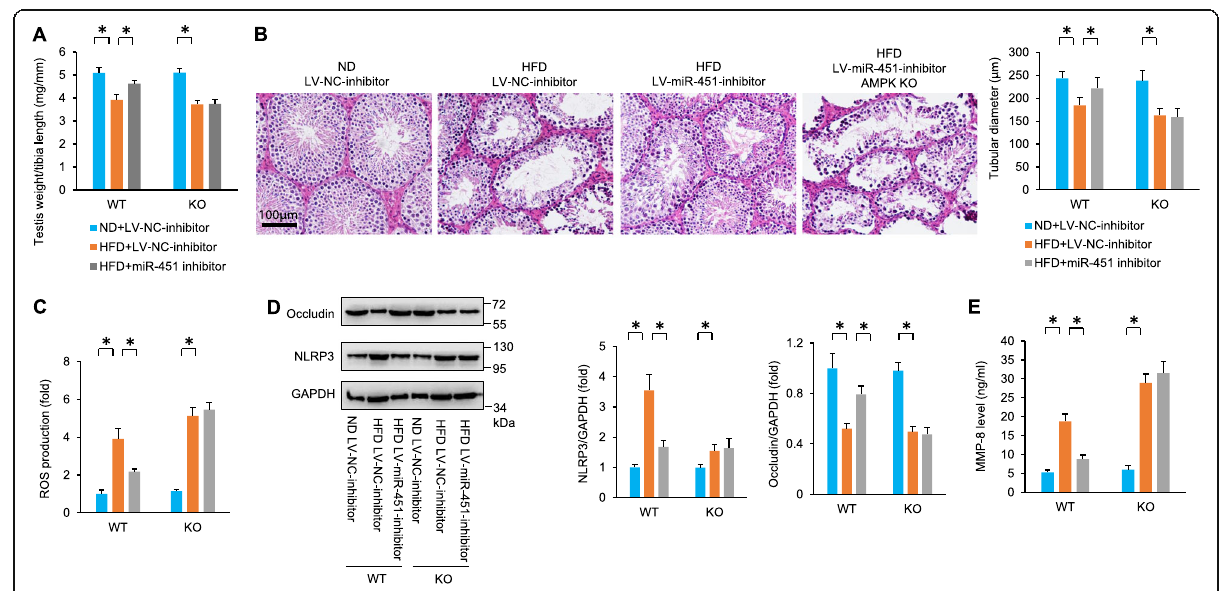
Fig. 8 miR-451 inhibition lost protection in AMPK α -deficient mice. A Statistical results of the ratio of testis weight and tibia length in the indicated groups ( n = 10). B HE staining of the testes and the tubular diameter from the indicated groups ( n = 6). C ROS production in the testes of obese mice ( n = 6). D NLRP3 and occludin protein expression in the testes of obese mice ( n = 6). E MMP-8 level in the testes of obese mice ( n = 6). Data are presented as the mean ± SD. The statistical analysis was carried out by one-way ANOVA. * P < 0.05 vs the matched